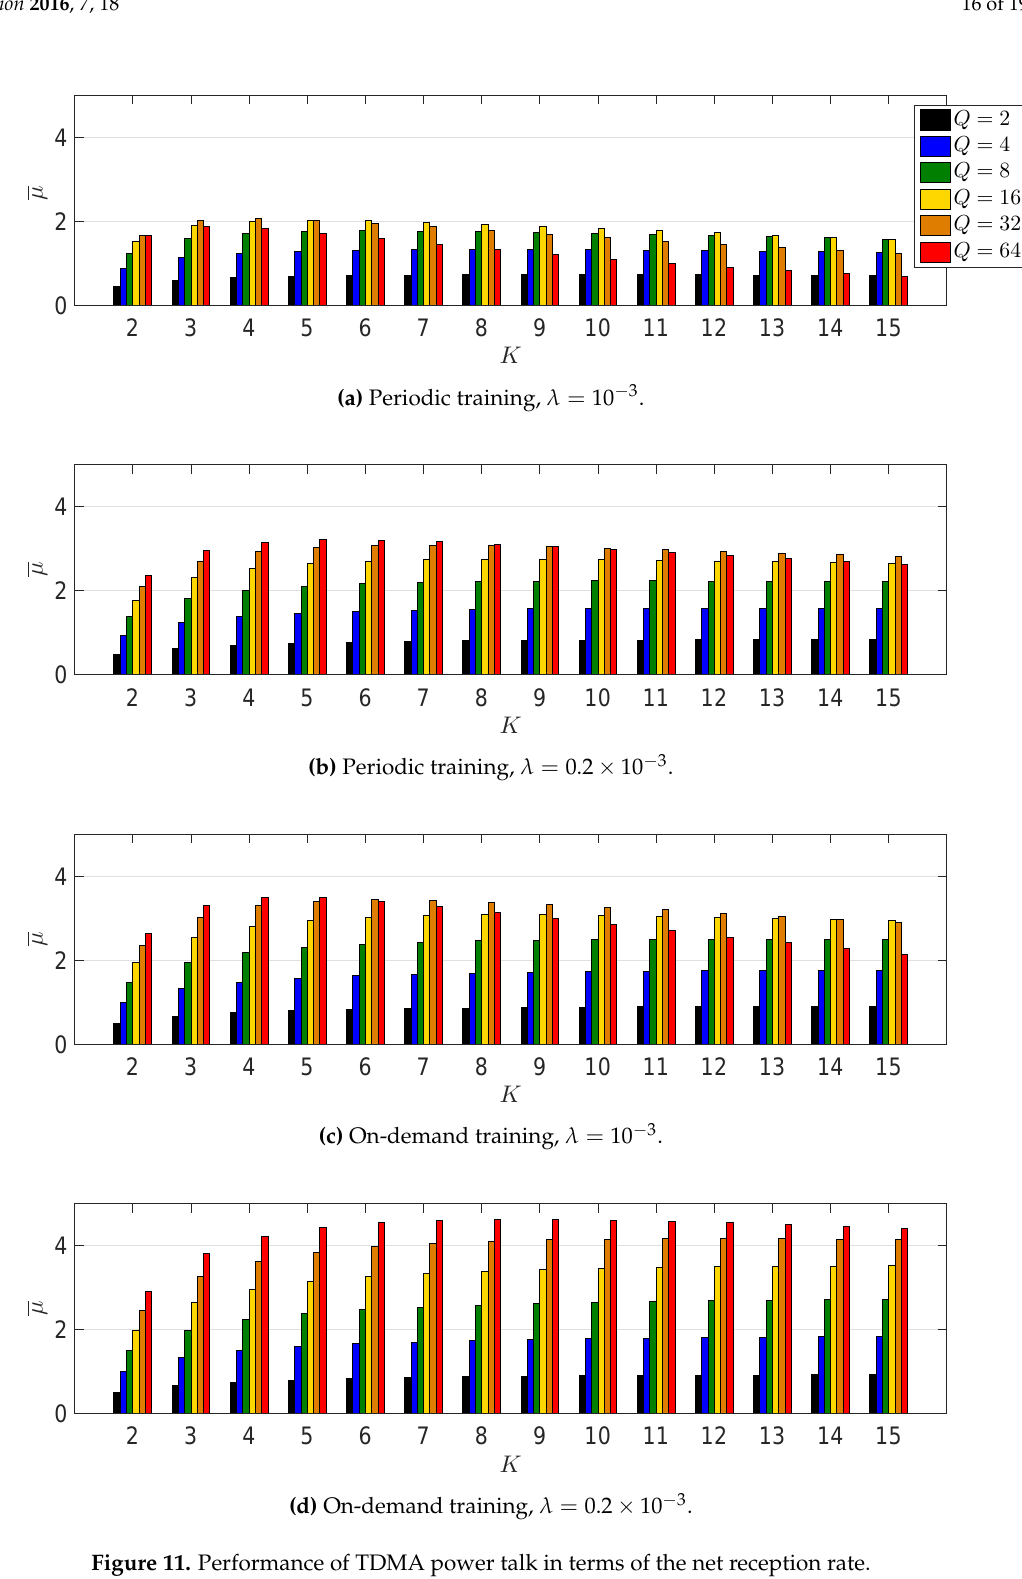
Figure 11. Performance of TDMA power talk in terms of the net reception